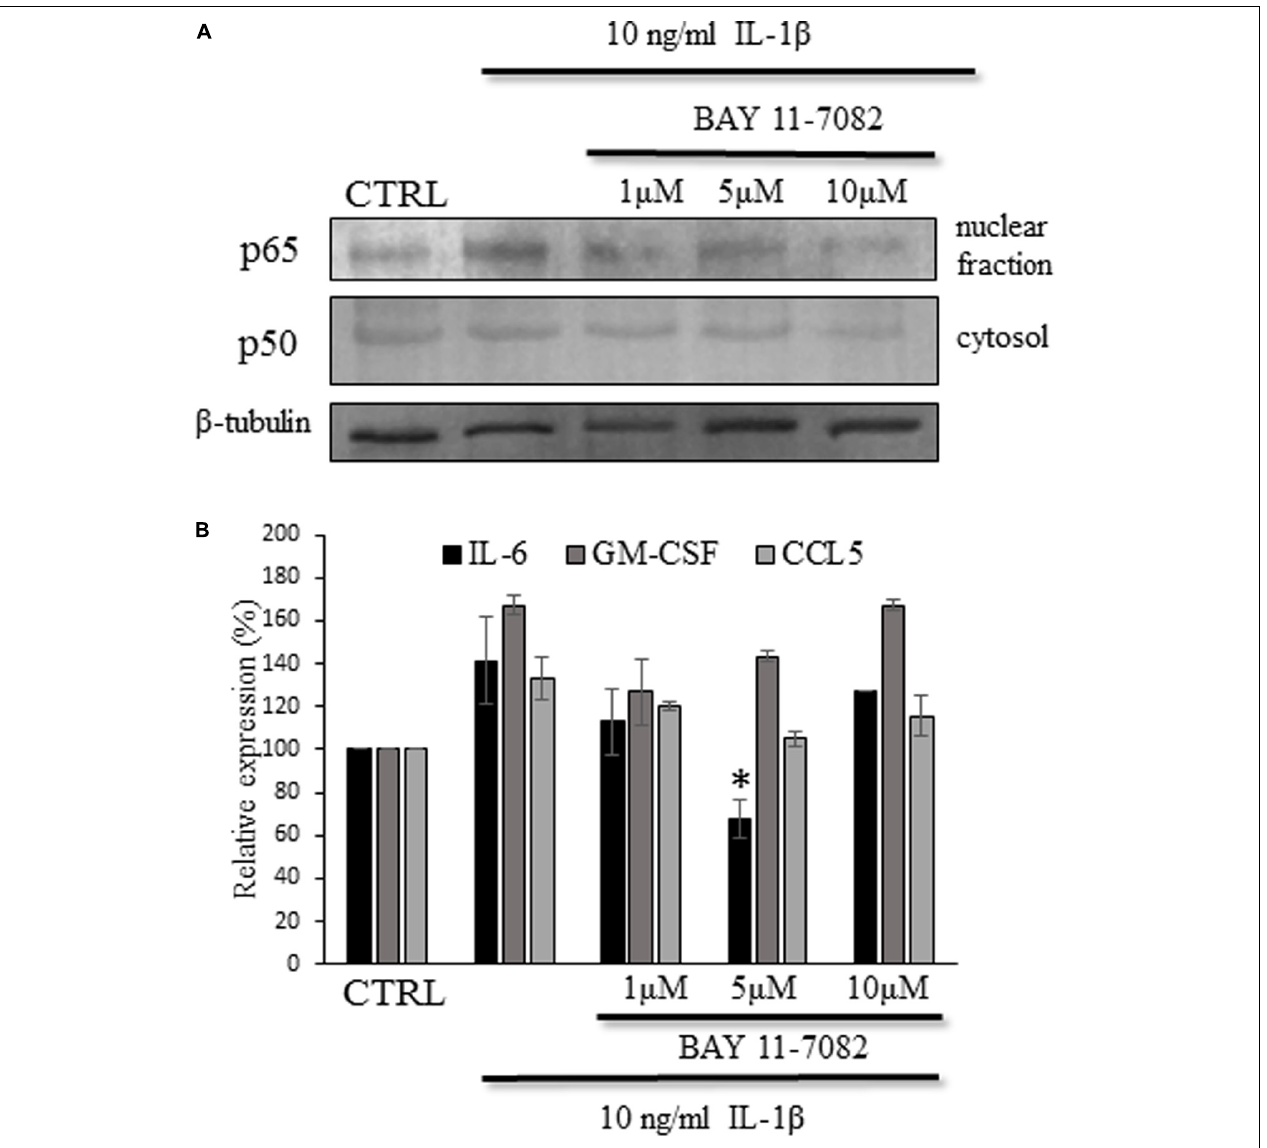
FIGURE 9 | IL-6 expression was attenuated by the BAY 11-1082 inhibitor of the NF- κ B signaling pathway. (A) Representative immunoblot show decreased p65 expression in the nuclear fraction upon BAY 11-1082 treatment. (B) Histogram shows cytokine levels determined by ELISA method. The IL-6 production of the astrocyte cultures is significantly attenuated. Data are shown as mean ± SEM of three independent experiments in duplicate. One-way ANOVA, followed by Student-Newman-Keuls pairwise comparison, ∗ p <